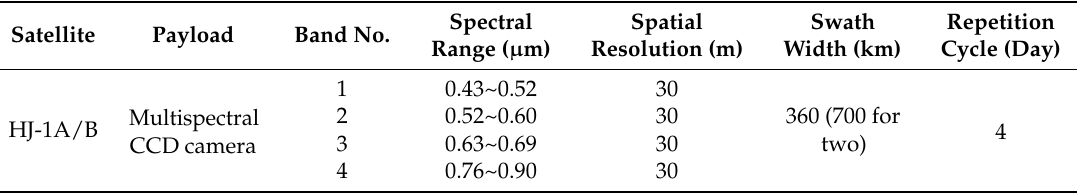
Table 3. Technical specifications for the HJ-1A/B